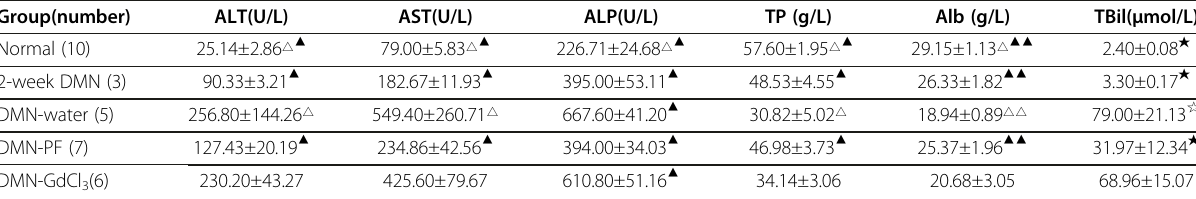
Table 2 Effects of PF on serum parameters in DMN-induced rat liver fibrosis ( (cid:1) x ± s)